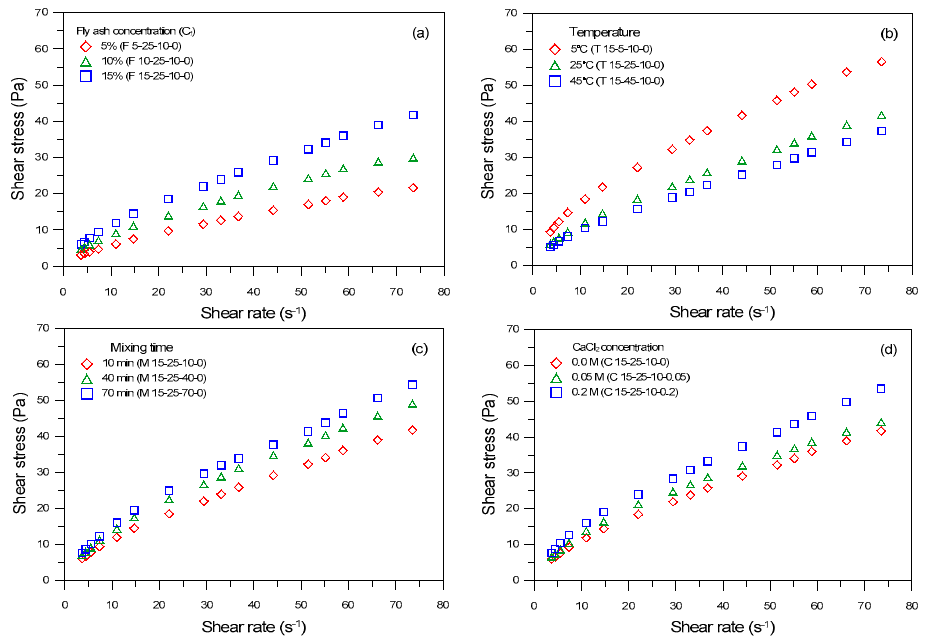
Figure 3. Effects of ( a ) fly ash concentration; ( b ) temperature; ( c ) mixing time; and ( d ) CaCl 2 concentration on the rheogram of fly ash mixed with tailings slurries.